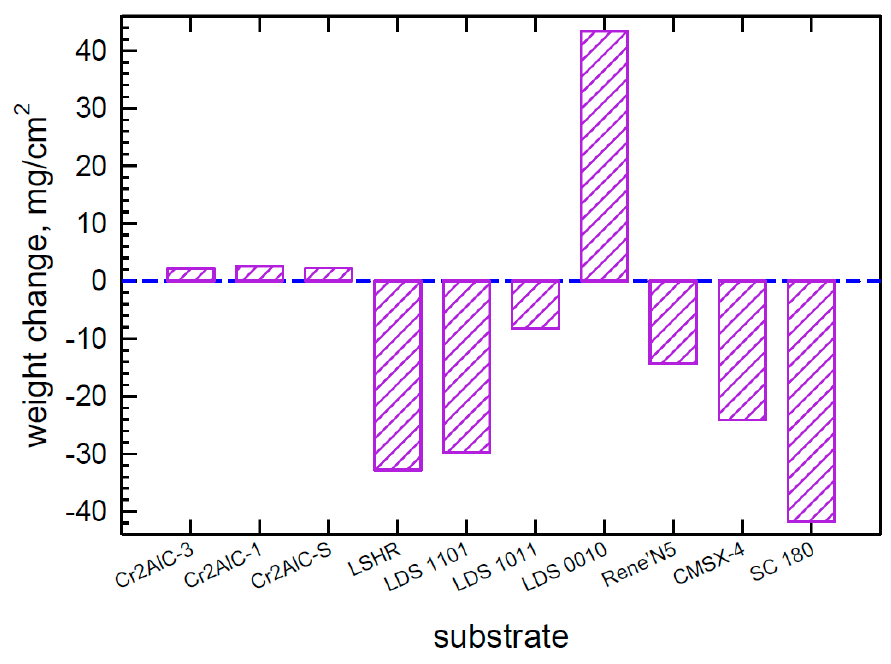
Figure 1. Bar chart comparing final 300 h weight change of Cr 2 AlC, LSHR disk alloy, and the six present single crystal superalloys (SXSA) in LTHC re-coat furnace tests at 700 °C. (80Na-20K) 2 SO 4 salt spray, 0.5 mg/cm 2 every 50 h, 25 h heating cycles. pSO 2 = 300 ppm in air. Includes results from Reference [4].